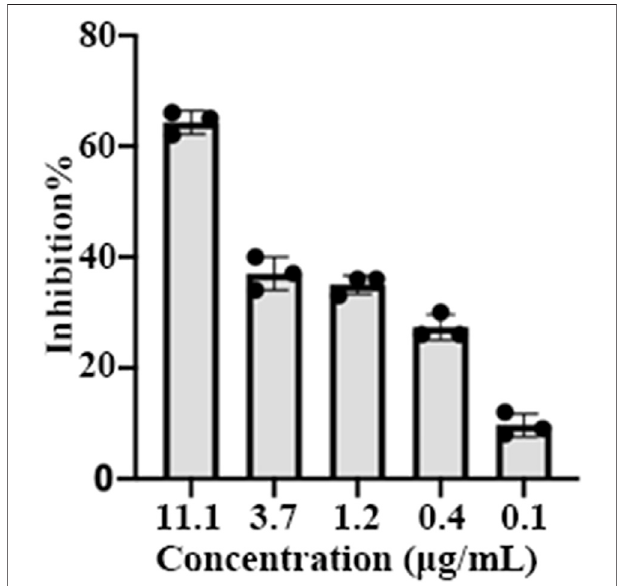
FIGURE 3 | Inhibition of pseudovirus by EPSs from H . hispanica . Pseudoviruses of SARS-CoV-2 were incubated with 3-fold serially diluted EPSs for 1 h and then transferred into pre-plated Vero E6 cells, followed by incubation for 24 h. Finally, the cells expressing GFP were measured by using a fl ow cytometer after lysed by trypsin.